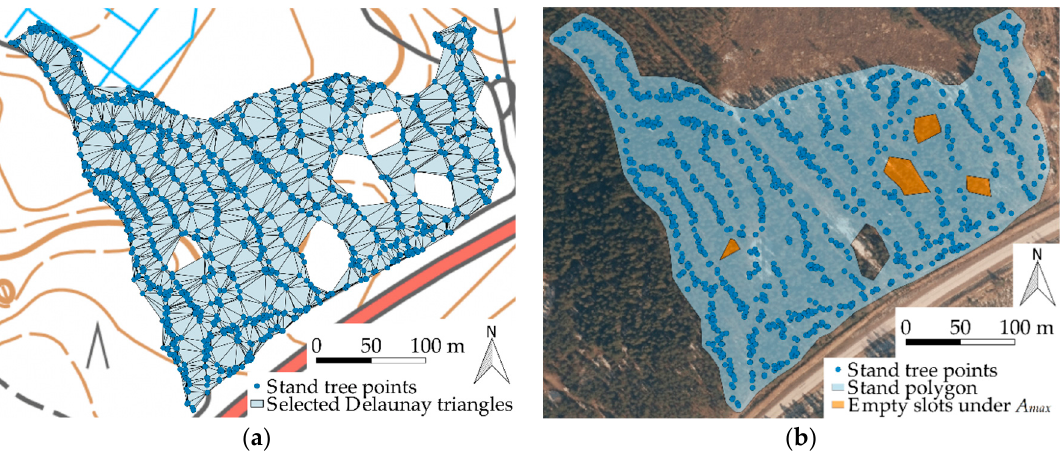
Figure 6. Empty slots appear into thinning stand during polygon formation. The ETRS-TM35FIN (EPSG:3067) coordinate system is used in the figure. Base map and aerial image © National Land Survey of Finland. ( a ) The selected triangles for stand delineation. ( b ) After polygon has been produced, the empty slots are smaller as the buffering of the stand polygon reduces their area. The empty slots which have area under A max are indicated in the figure.